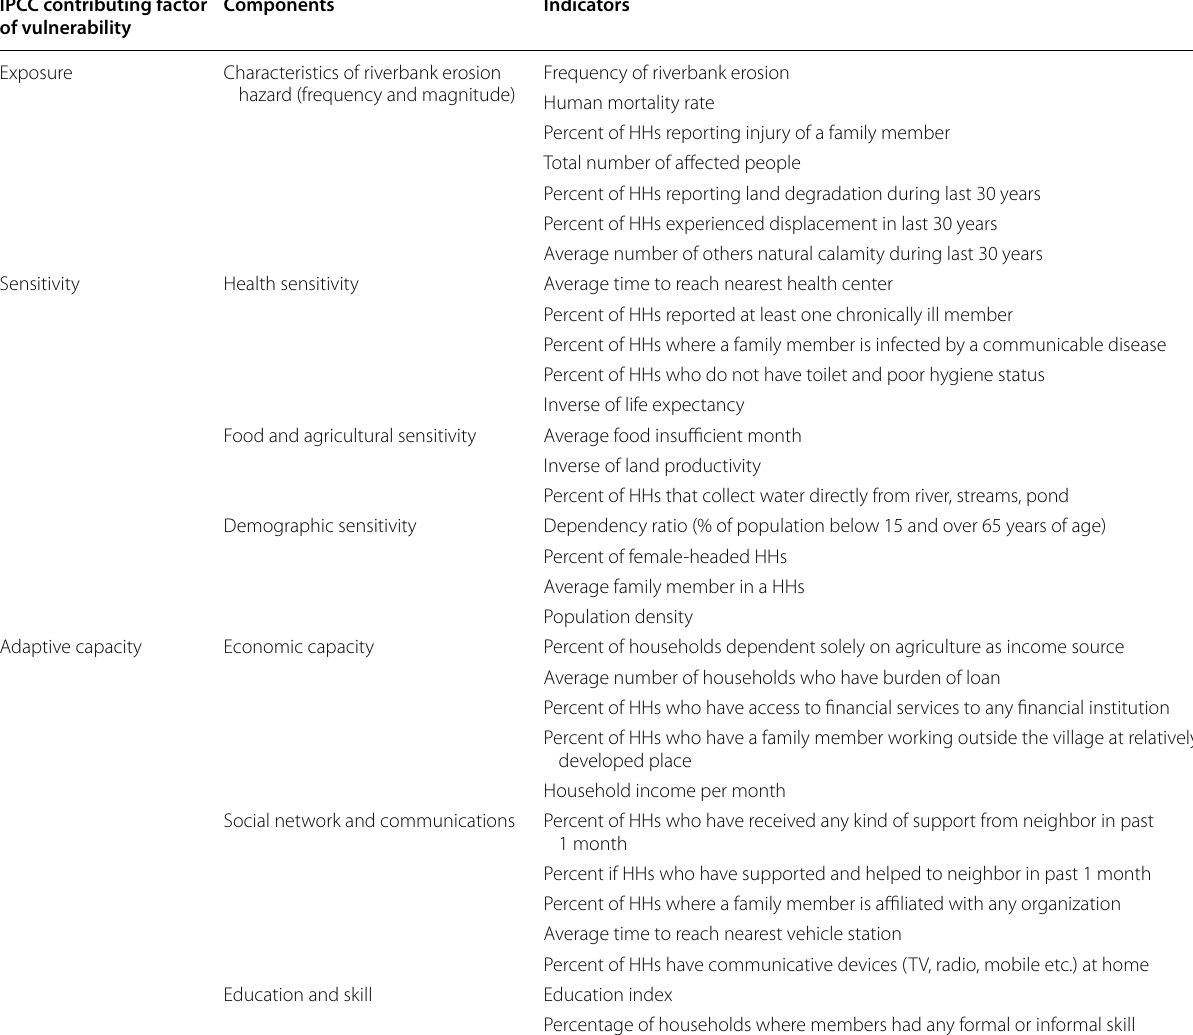
Table 1 Description of IPCC (2001) contributing factor, major components and indicators of